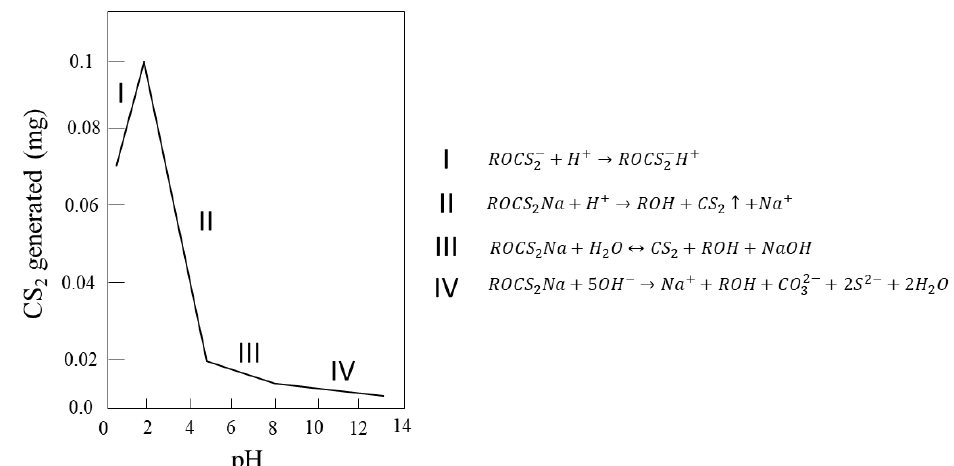
Figure 10. Formation of carbon sulfide at different pH values from 0.05 wt% SIBX solution (adapted from Shen et al. [33]).